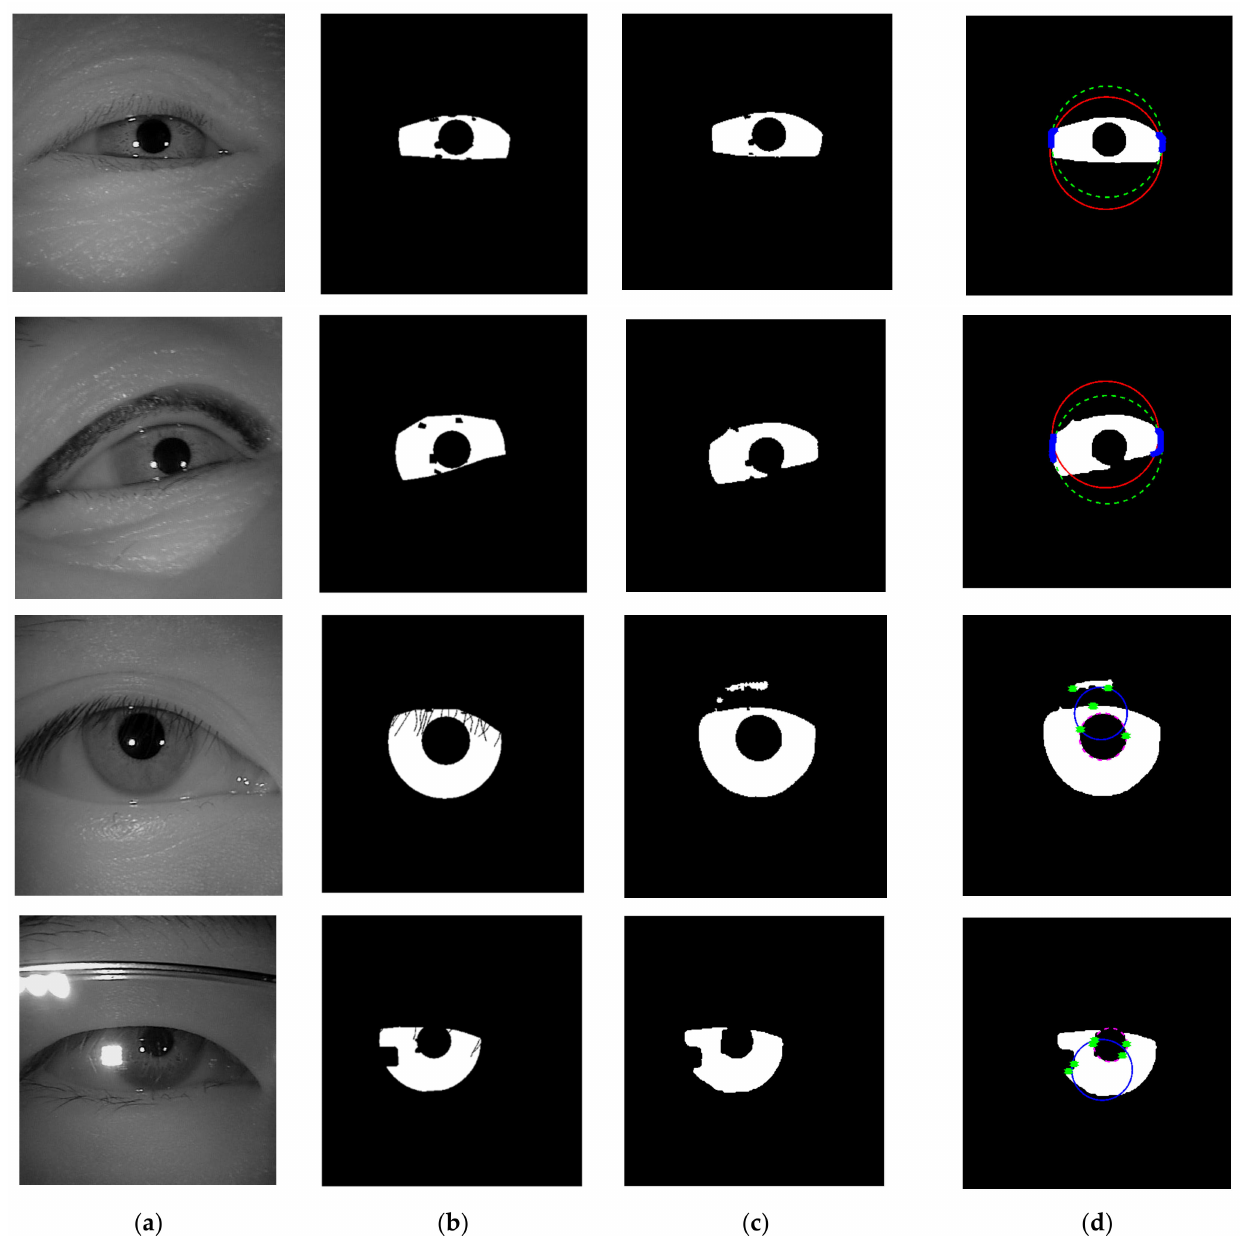
Figure 15. Failure cases because of the strong occlusion. ( a ) Input images; ( b ) ground-truth masks; ( c ) predicted masks; ( d ) estimated inner and outer boundary. The dashed lines denote the ground-truth and the solid lines denote the prediction. Blue dots denote the recovered saliency points of the iris, and green dots denote the recovered saliency points of the